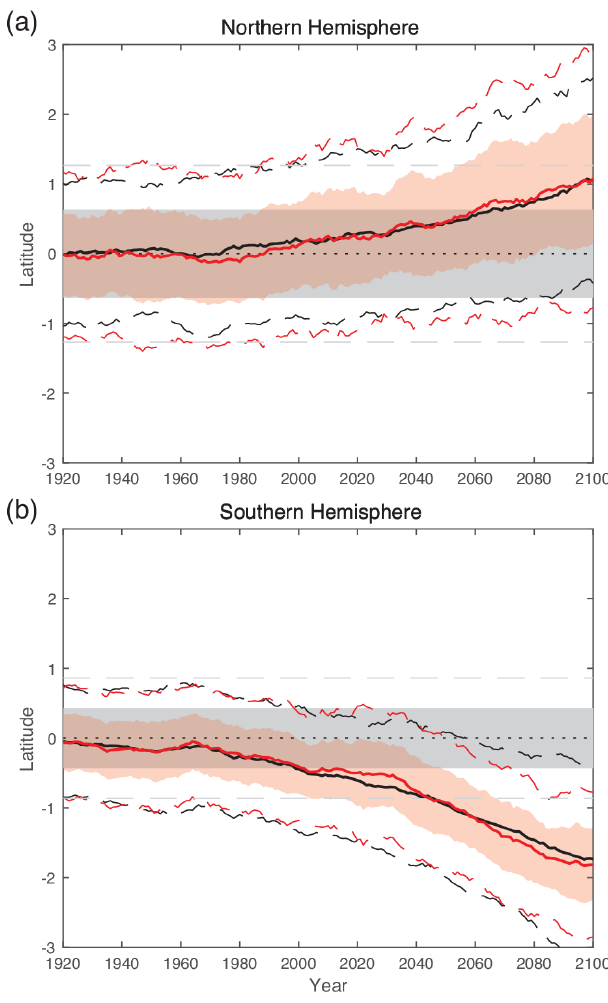
Figure 9. 1920–2100 time series of annual-mean Hadley cell edge latitude (as measured by PSI500 metric) from CMIP5 historical + RCP 8.5 and CMIP6 historical + SSP 5-8.5 runs. The multi- model mean (smoothed with 10-year running mean) for CMIP5 (CMIP6) models is plotted as a solid black (red) line. One stan- dard deviation range across the inter-model spread of CMIP6 mod- els is shown as red shading. Two standard deviation range across the inter-model spread of CMIP5 (CMIP6) models is plotted as black (red) dashed lines. One and two standard deviation ranges about the pre-industrial control latitude of CMIP6 models are shown as gray shading and gray dashed lines, respectively. All latitudes are plotted with respect to the multi-model mean pre-industrial control